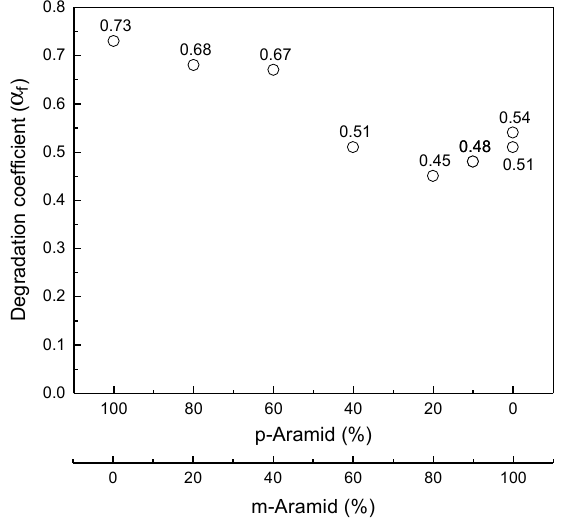
Figure 8. Relationship between degradation coefficient ( α f ) of the fitting Equation (3) and blend of p-Aramid/m-Aramid.